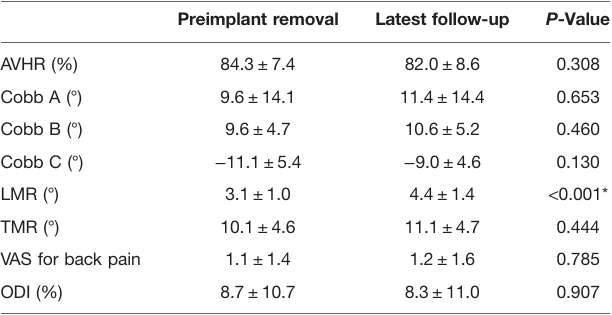
TABLE 4 | Results comparison of group A between preimplant removal and the latest